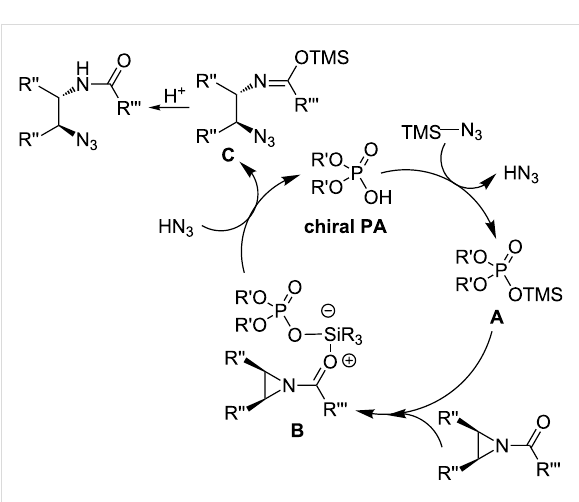
when the molar ratio of aziridine/nucleophile/catalyst is 1.0:1.5:0.1. For the unreactive acyclic and seven-membered Figure 5: The proposed mechanism for chiral phosphorous acid-